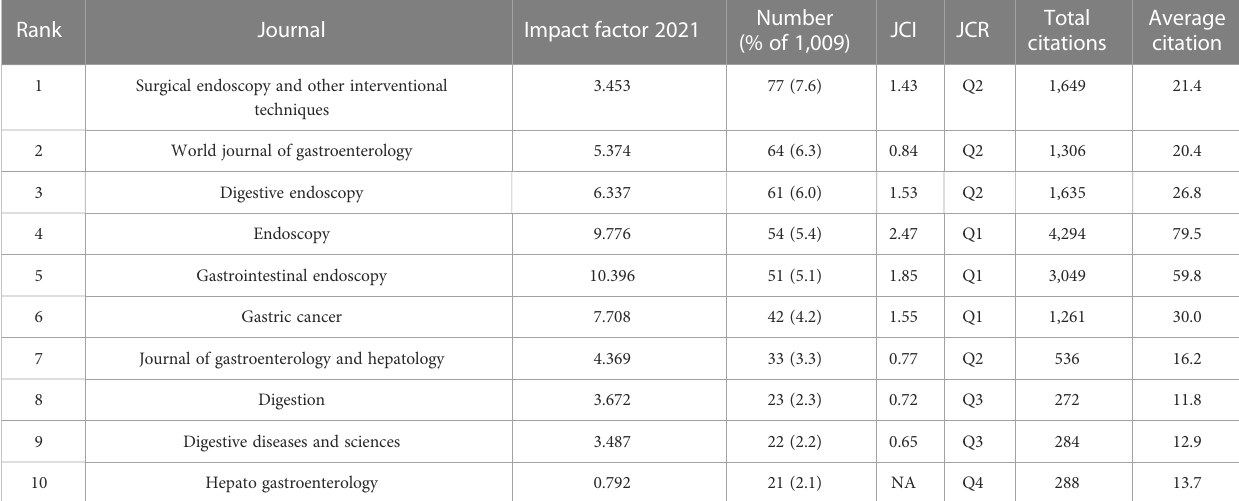
TABLE 3 Top 10 journals involved in endoscope on EGC.